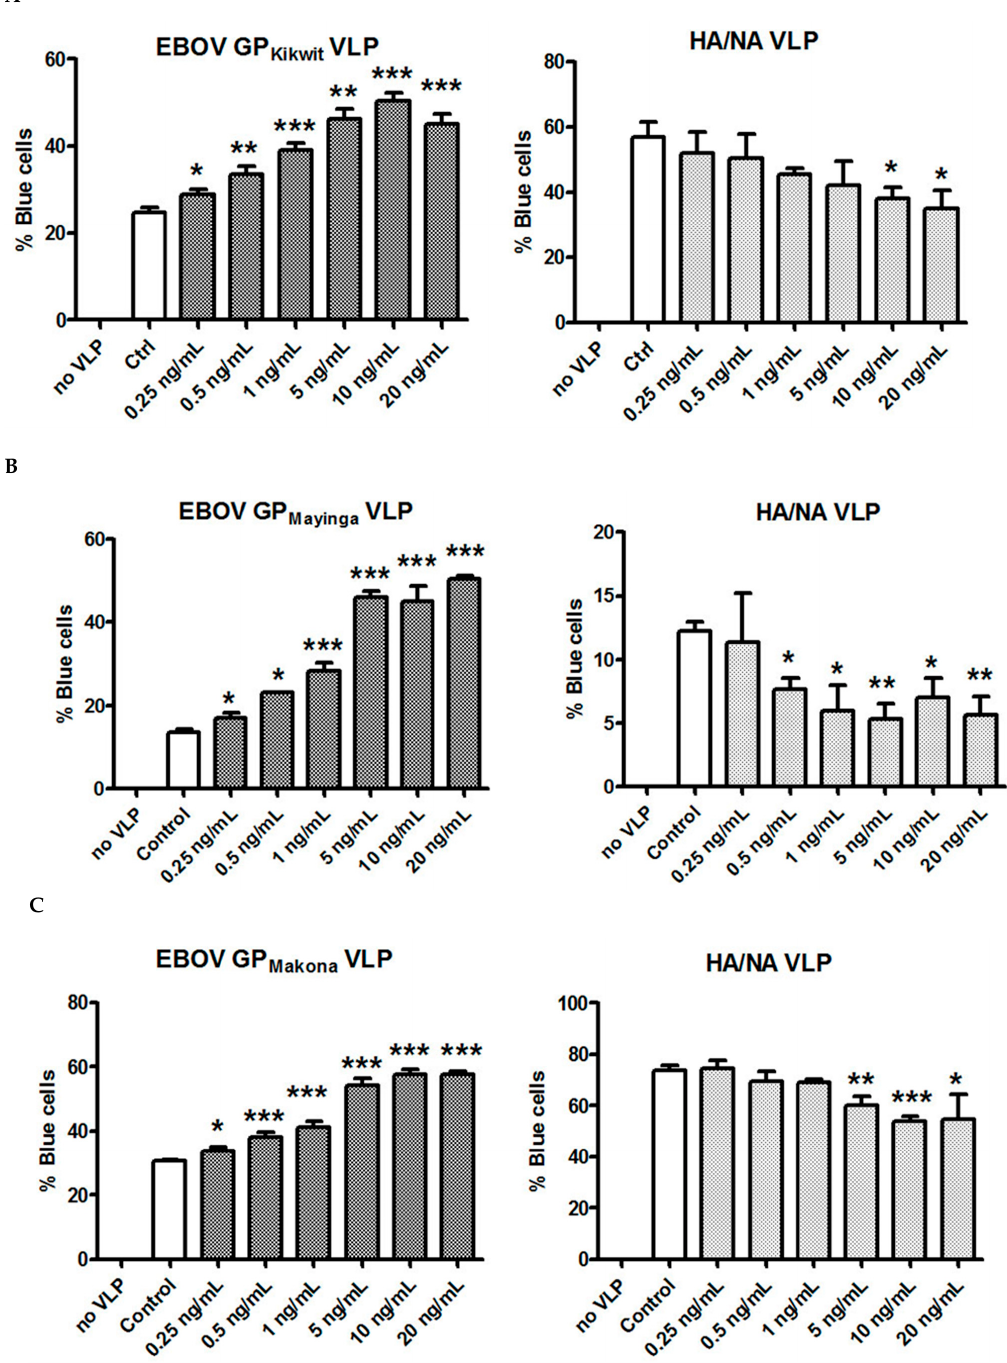
Figure 4. IL-10 enhances fusion of primary MDM with VLPs pseudotyped with EBOV GP in a dose-dependent manner, but has no significant effect or slightly inhibits entry of VLPs pseudotyped with influenza HA/NA. MDM from three different healthy donors were pre-incubated for 48 h with increasing concentrations of IL-10 and infected for 3.5 h with VLPs pseudotyped with the surface glycoproteins of the Kikwit (Panel A ), Mayinga (Panel B ) or Makona (Panel C ) strains, respectively. Subsequently, the cells were washed, loaded with the fluorescent dye CCF2/AM and prepared for analysis by Laser Scanning Cytometry as described in Material and Methods. * p ≤ 0.05; ** p ≤ 0.01; *** p ≤ 0.001.